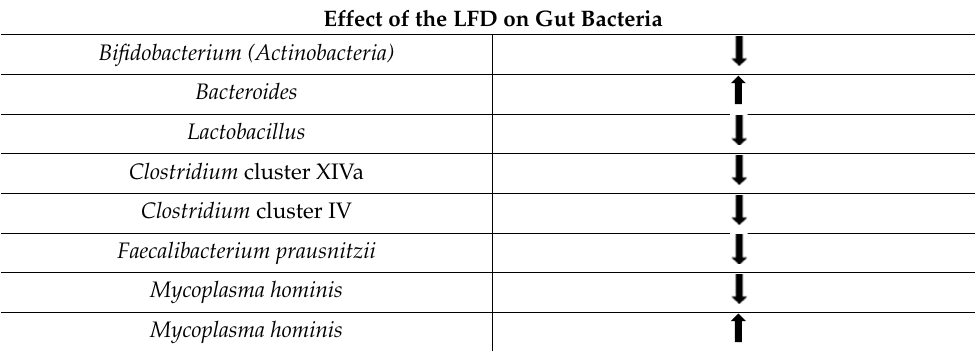
Table 1. Effect of the LFD on gut microbiota [7,8,29,30]. Effect of the LFD on Gut Bacteria Bifidobacterium (Actinobacteria) Bacteroides Clostridium cluster XIVa